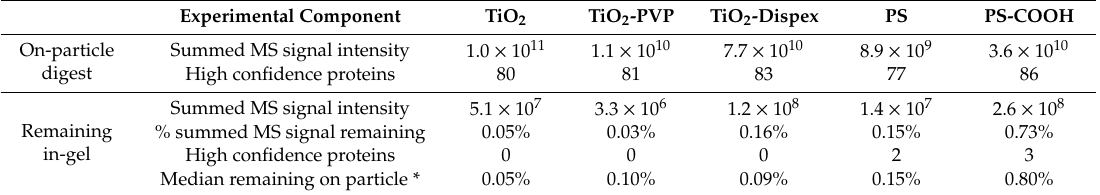
Table 2. Recovery of proteins that constitute the NM protein corona—both the fraction in solution and the fraction remaining on the NM post extraction. Experimental Component TiO 2 TiO 2 -PVP TiO 2 -Dispex PS PS-COOH On-particle